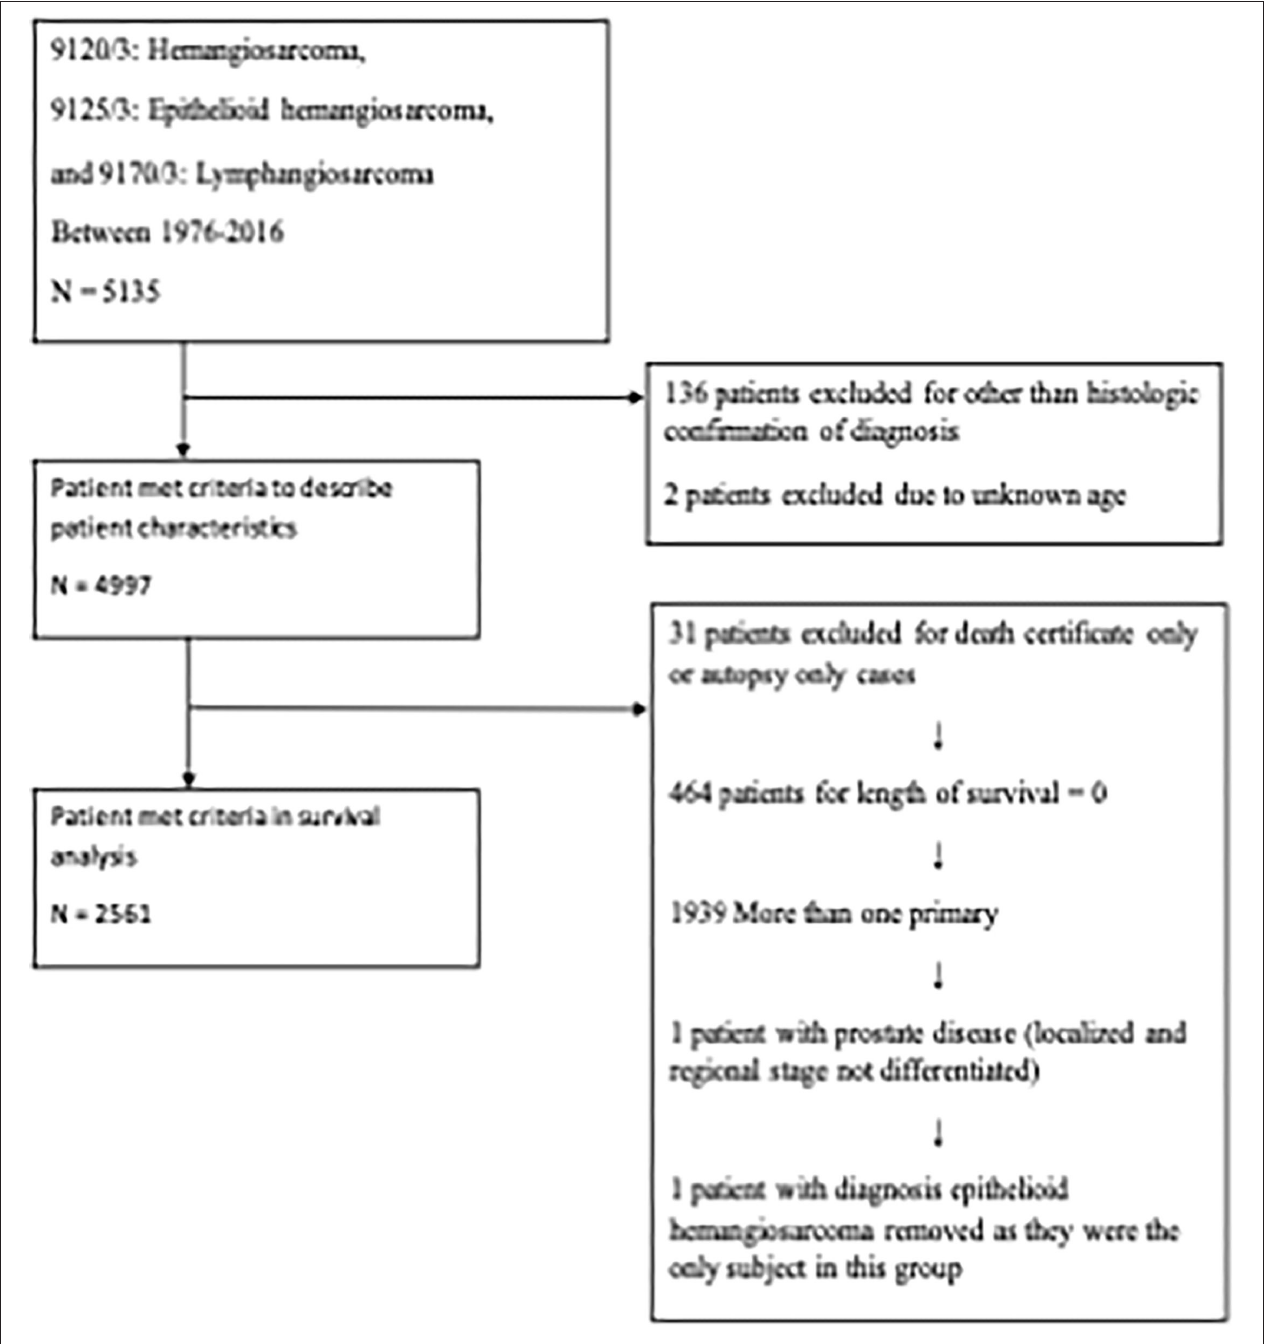
FIGURE 1 | Flow diagram. The Surveillance, Epidemiology, and End Results (SEER) Program 18 Regs Custom Data (with additional treatment fields) was used. All cases from 1976 to 2016 were included.